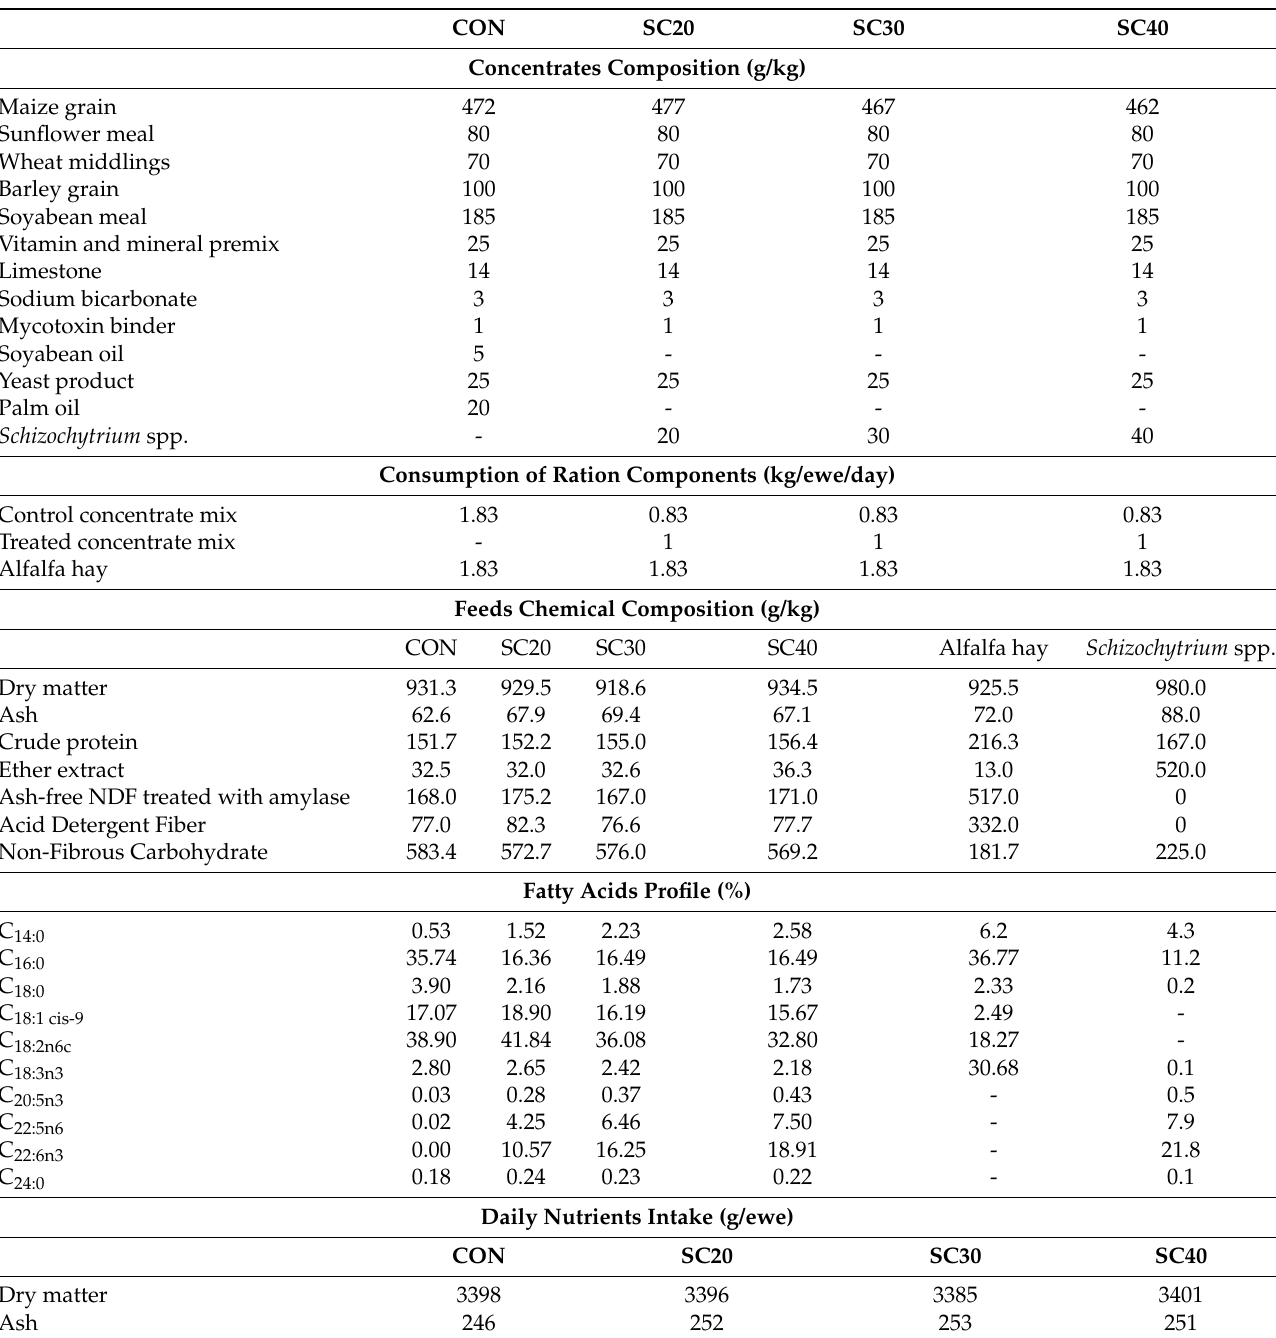
Table 1. Main characteristics of diets (CON, SC20, SC30, and SC40) consumed by ewes involved in the trial. Concentrate composition (g/kg), ration components consumption (g/kg) and Ingredients of concentrate (g/Kg), ration components (Kg/ewe/day) and chemical composition (g/day) of the diets were administered to the four groups (CON, SC20, SC30, and SC40) of ewes involved in the trial